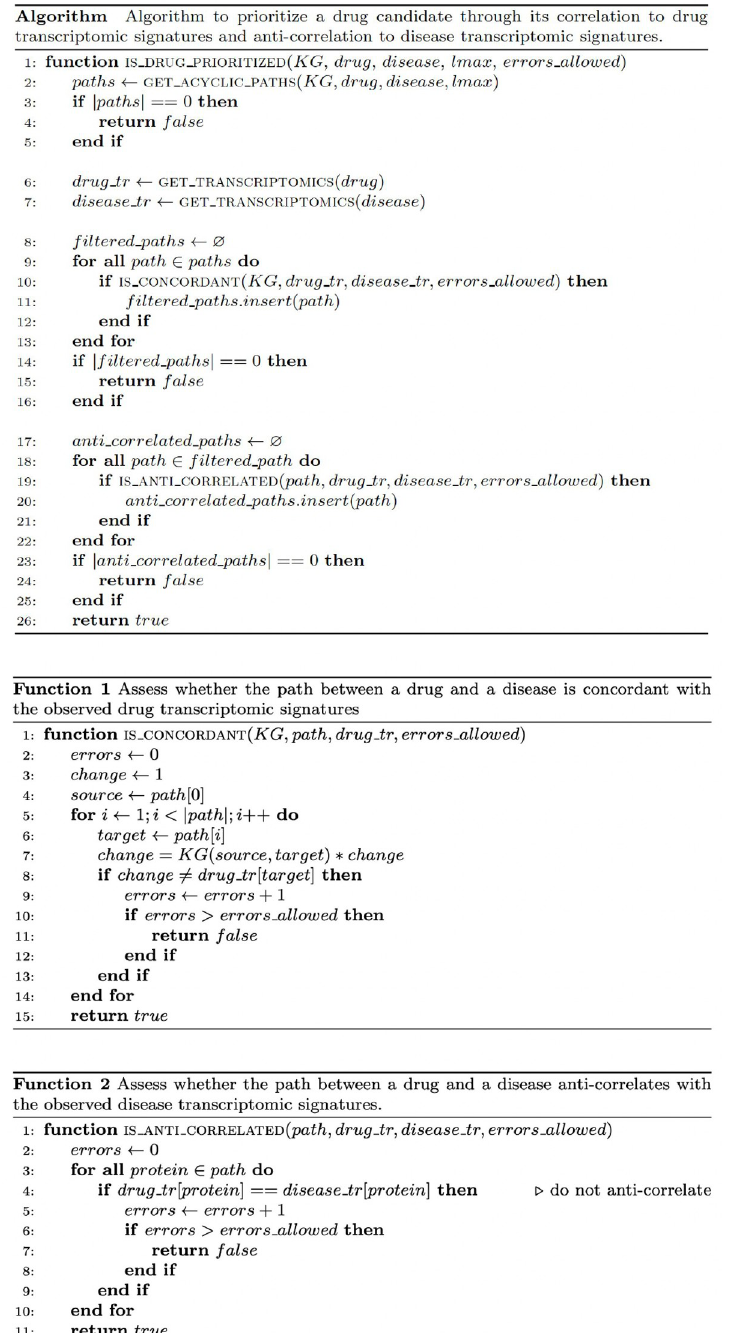
Fig 3. Pseudocode of the RPath algorithm. Given a KG, drug, disease and a defined path length (i.e., lmax) , the core function of the algorithm, is_drug_prioritized , returns whether a drug should be prioritized or not. For this, the function calculates all acyclic paths between a drug-disease pair in the KG. For each path found, drug-perturbed (i.e., drug_tr) and disease-specific (disease_tr) transcriptomic signatures are overlaid onto their corresponding protein nodes. The function then prioritizes the drug if at least one path is concordant with the observed drug-perturbed transcriptomic signatures (evaluated via Function 1 , is_concordant ) and the same path is anti-correlated with the observed disease-specific transcriptomic signatures (evaluated via Function 2 , is_anti_correlated ). Paths which match both the drug-perturbed signatures and contradict disease-specific signatures are then returned by RPath as promising drug